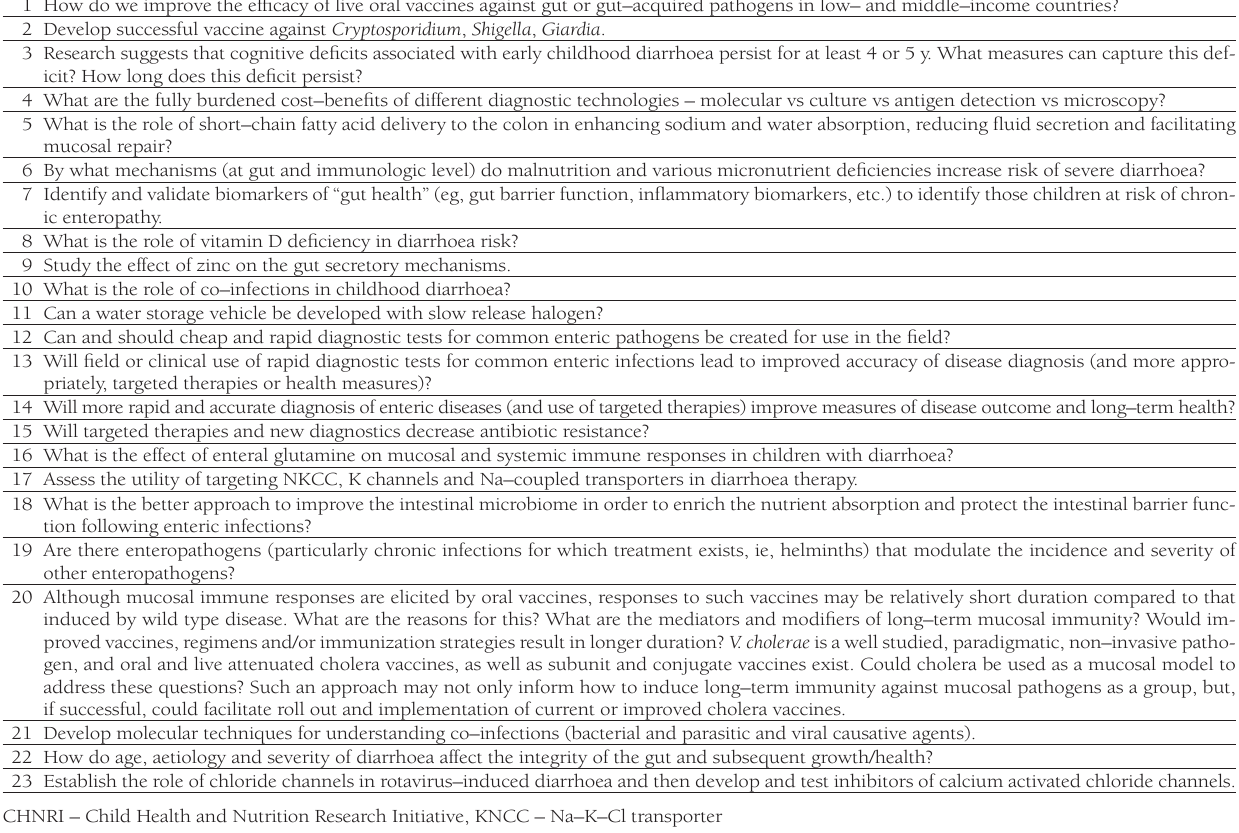
Table 1. Discovery related questions identified by the CHNRI